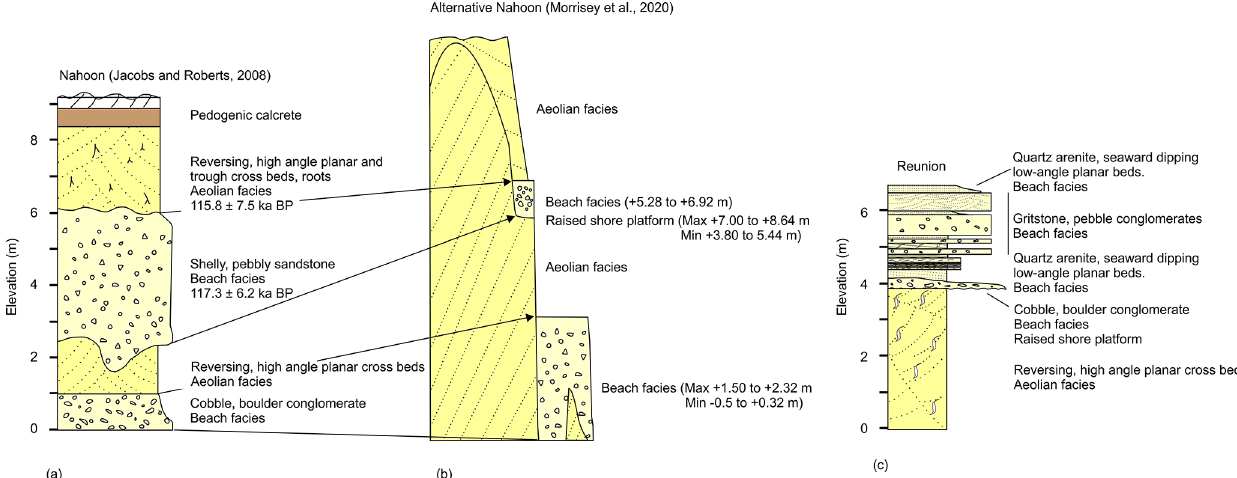
Figure 6. Key sites in South Africa with sedimentary but not fully dated records of sea-level variability during MIS 5e. Locations on Fig. 1. (a) Sequence at Nahoon (after Jacobs and Roberts, 2009). A similar lowermost beach facies represents a possible early MIS 5e highstand at ∼ + 1m, with a regression represented by the aeolian facies, followed by a second transgression. (b) Alternative interpretation of the